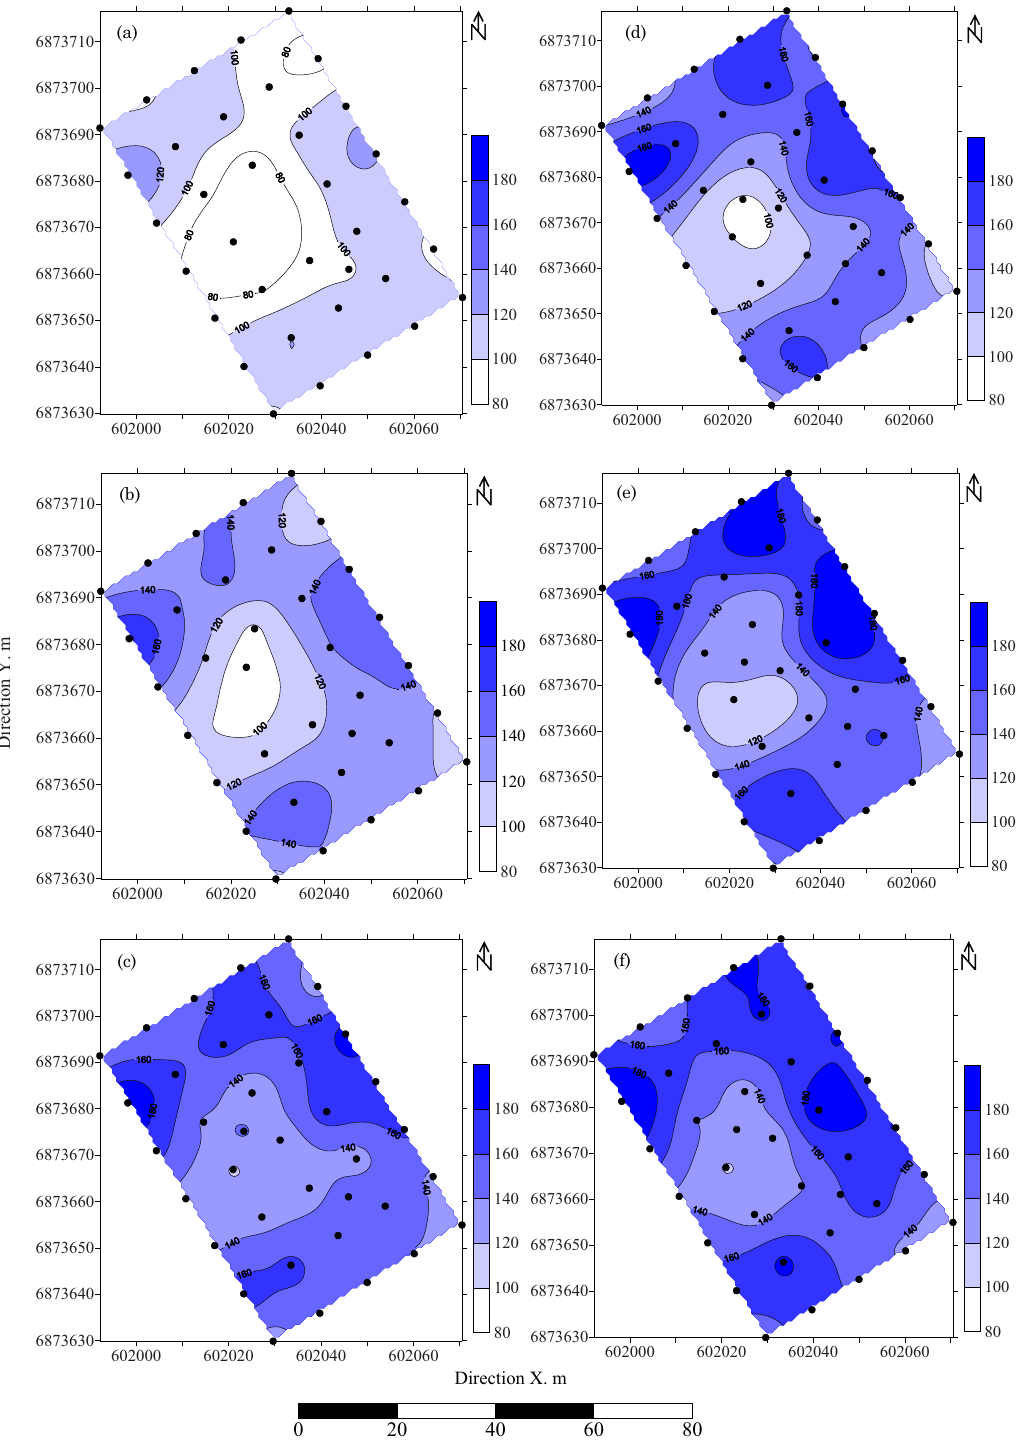
Figure 4. Maps of water storage (mm) in the 0.00-0.30 m layer of a Cambisol. Minimum (a), medium (b) and maximum storage (c) in 2008/2009; minimum (d), medium (e) and maximum storage (f) in